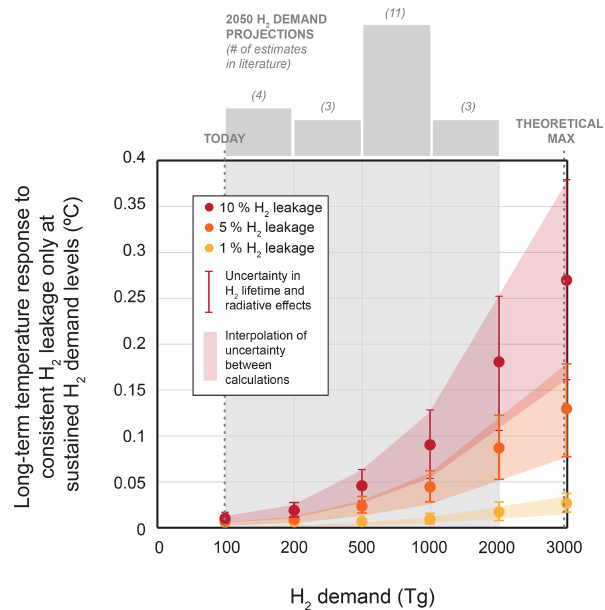
Figure 6. Long-term temperature responses (in ◦ C) to different lev- els of hydrogen leakage based on sustained hydrogen demand levels (in Tg). The red, orange, and yellow markers and shading represent leakage levels of 10%, 5%, and 1%, respectively. Uncertainty is based on uncertainties in both hydrogen’s soil sink and, therefore, lifetime ( ∼ ± 20%) as well as uncertainties in hydrogen’s radiative effects ( ∼ ± 20%). Markers indicate calculations, and shaded re- gions represent interpolation. The histogram and shaded gray area characterize projections of hydrogen demand for the year 2050 in the published literature (see Table 3). The theoretical max is an es- timate based on using hydrogen to supply the total final energy de- mand globally in 2050 based on decarbonization